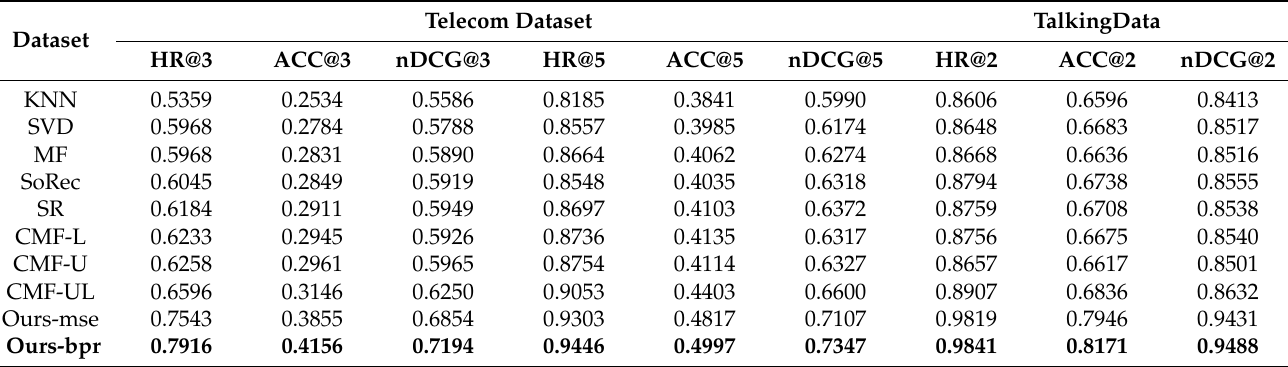
Table 2. Recommendation Results Under 50% Data